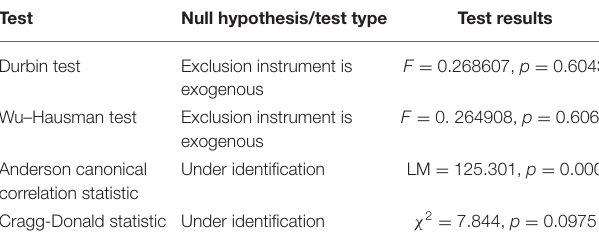
TABLE 4 | Tests for the exclusion